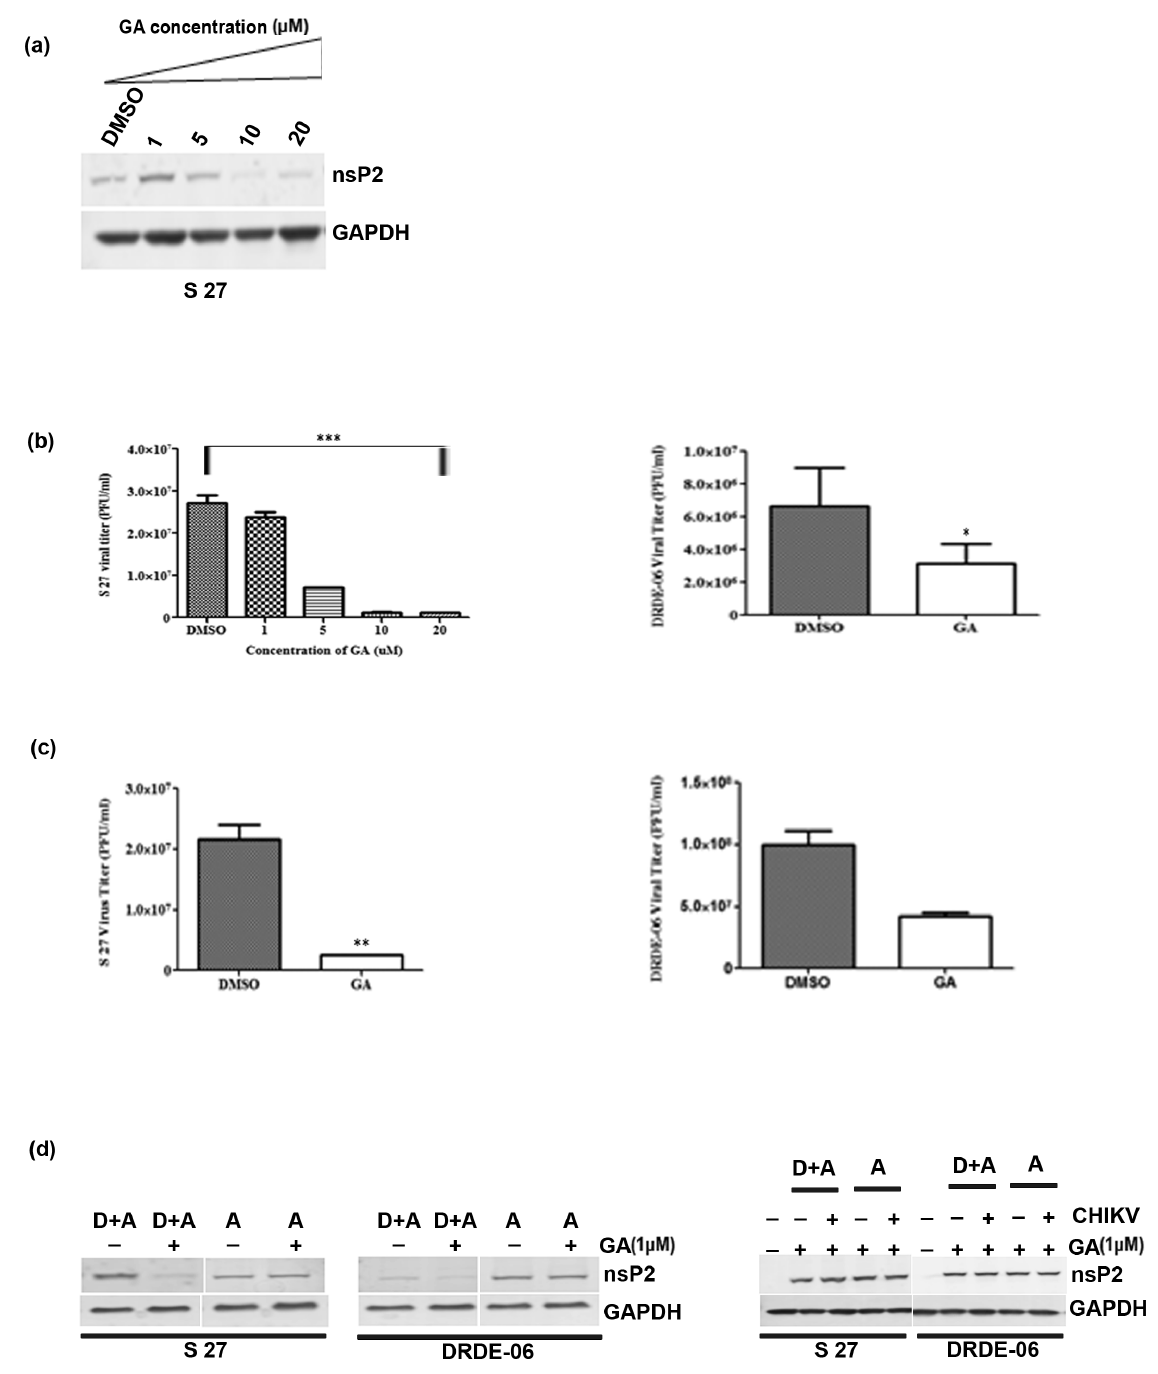
Figure 5. Reduction in nsP2 level and virus titer when cells were serum starved. Vero cells were serum starved for 48 h and infection was performed using CHIKV strains with MOI 0.1 (a) Vero cells were infected with S 27 virus and treated with different concentrations of the drug (1, 5, 10, 20 m M) and cells were harvested at 14 hpi. Western blot was performed with cell lysates and probed with nsP2 antibody (b) Vero cells were infected either with S 27 or DRDE-06 and drug treated supernatants were collected at 14 hpi. Viral titre was determined by plaque assay. The data represents the mean 6 SD with three independent experiments (* p , 0.05). (c) Vero cells were infected with either S 27 or DRDE-06 and the drug (1 m M) was added during infection as well as after infection and the supernatants were collected at 14 hpi and plaque assay was performed to determine virus titre. Data of three independent experiments are represented as mean 6 SD (* p , 0.05). (d) The cells were harvested from the virus infected dishes as mentioned in 5(c) and Western blot was performed using the cell lysates collected from serum starved and nutrient rich condition (with and without 1 m M GA) and was probed for nsP2 and GAPDH antibody. A= addition of GA after infection. D + A= addition of drug during as well as after infection.